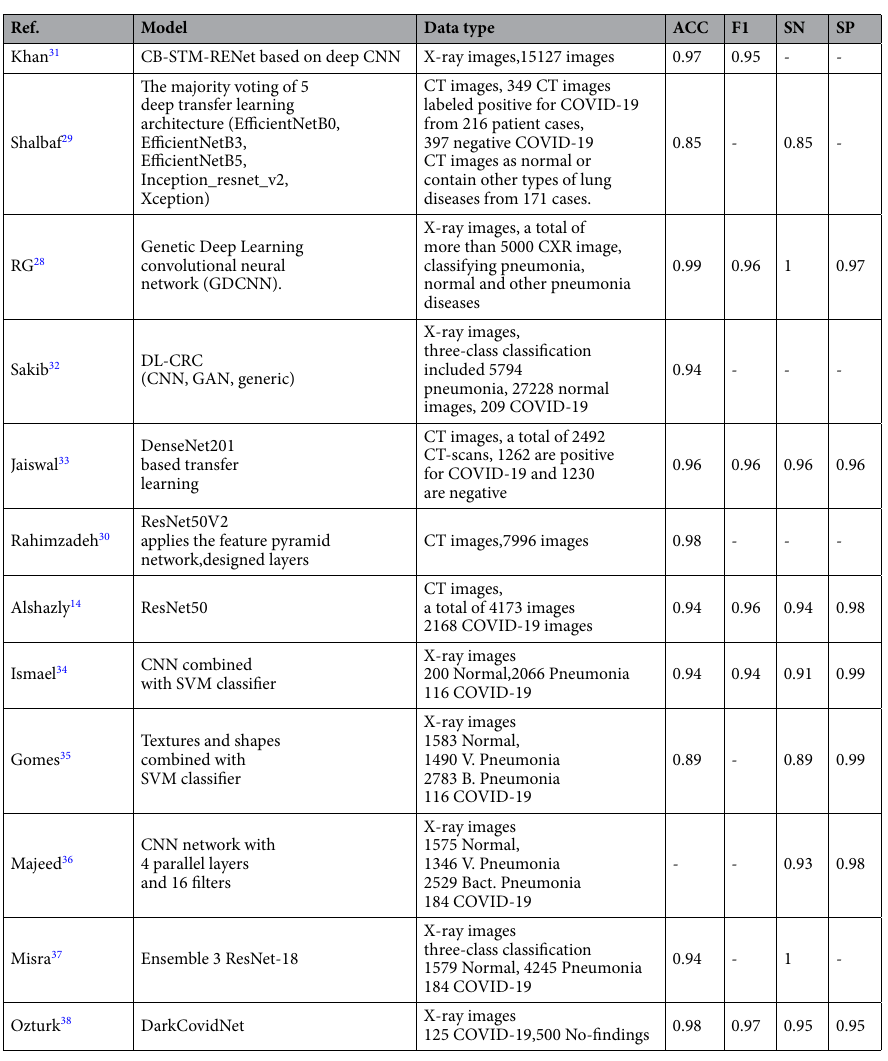
Table 6. Deep learning methods and techniques used in COVID-19.